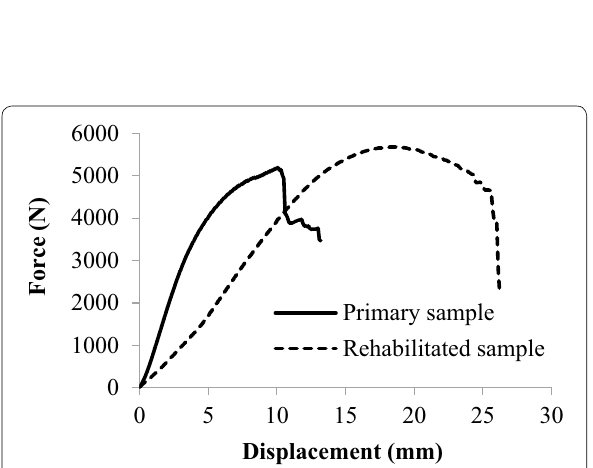
Fig. 8 Force–displacement diagrams of the